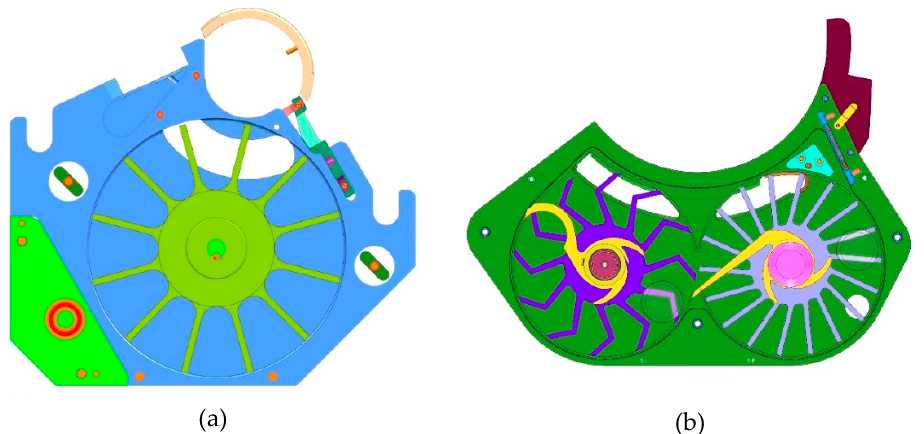
Figure 1. Feed frame of XL 100 ( a ) exhibiting a single chamber equipped with one dosing paddle and feed frame of XL 400 ( b ) consisting of a dosing chamber (left) and metering chamber (right) equipped with a dosing and metering paddle, respectively. Table 1. Process parameters of residence time distribution experiments at XL 100 and XL 400.